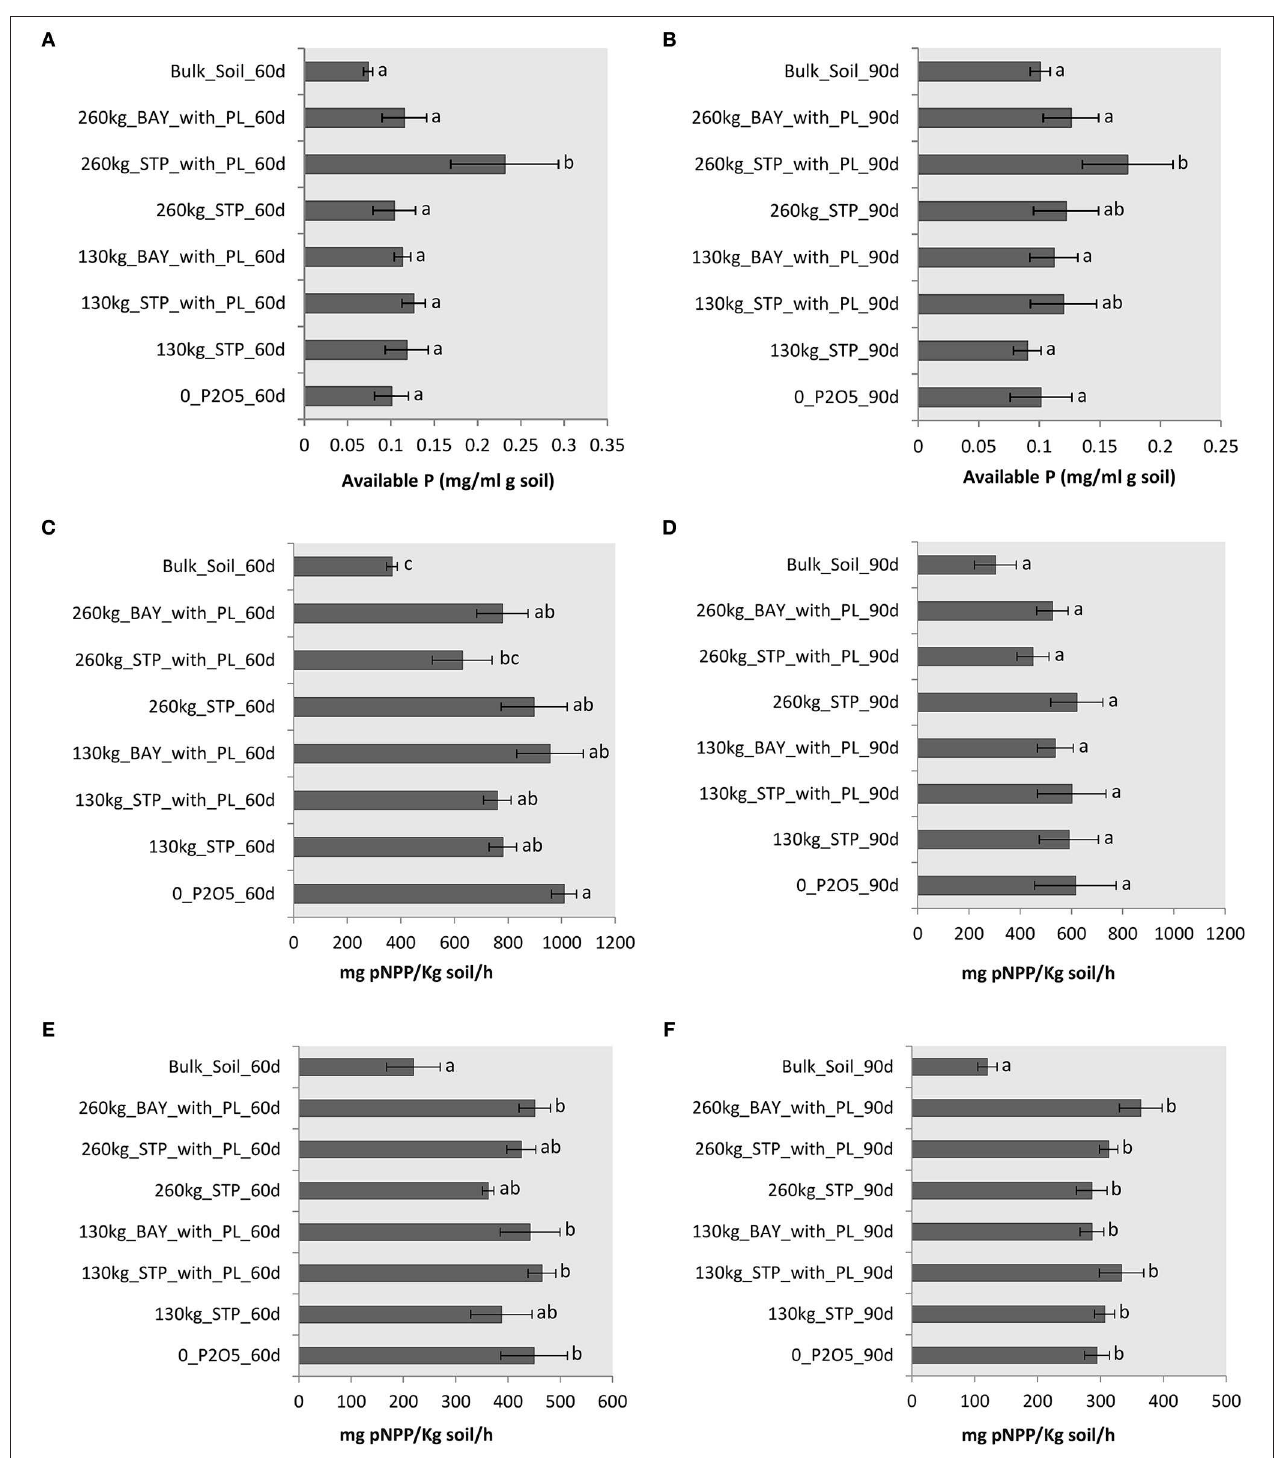
FIGURE 5 | (A) Phytase activity, measured 60 days after sowing maize; (B) Phytase activity, measured 90 days after sowing maize; (C) Phosphatase activity in pH 6.5, measured 60 days after sowing maize; (D) Phosphatase activity in pH 6.5, measured 90 days after sowing maize; (E) Phosphatase activity in pH 11.0, measured 60 days after sowing maize; and (F) Phosphatase activity in pH 11, measured 90 days after sowing maize. Treatments (in each panel) that do not share a letter have a mean difference that is statistically significant based on Tukey’s pairwise test ( p < 0.05).